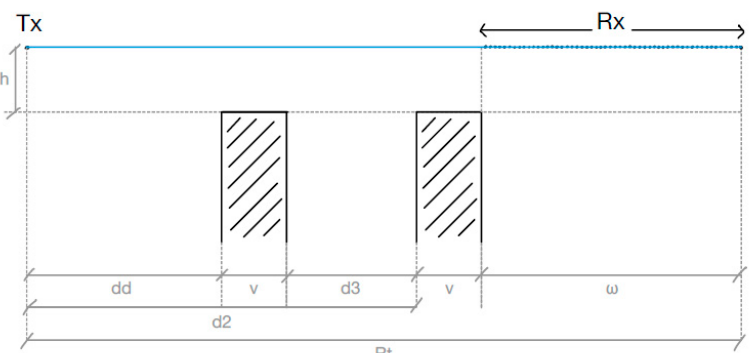
Figure 1. Scheme of the considered LOS scenario.